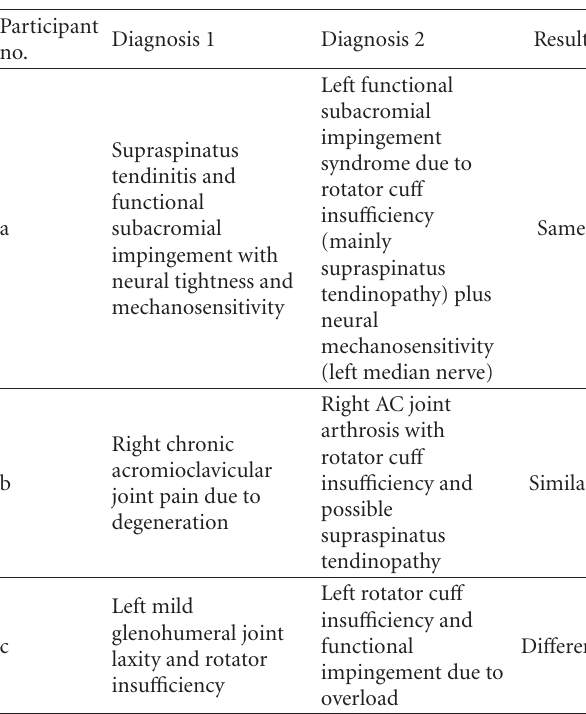
Table 1: Example of physical examination recording and coding. Table 2: An example of comparison of pathoanatomical